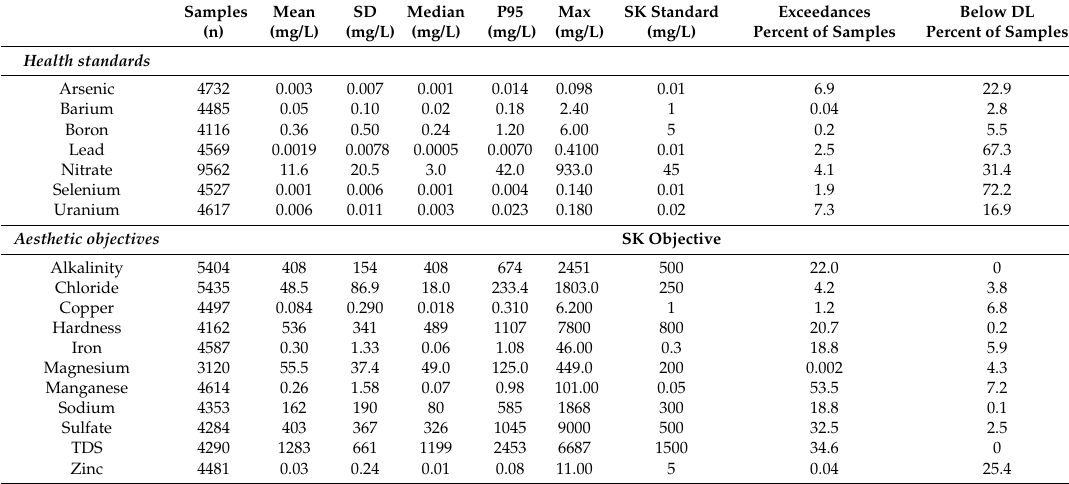
Table 1. Descriptive statistics for individual samples in public water supplies in Saskatchewan during 1985–2012, along with the Saskatchewan standards and objectives, percent of samples exceeding the respective standard or objective, and percent of samples below detection limit for the water parameters included in the